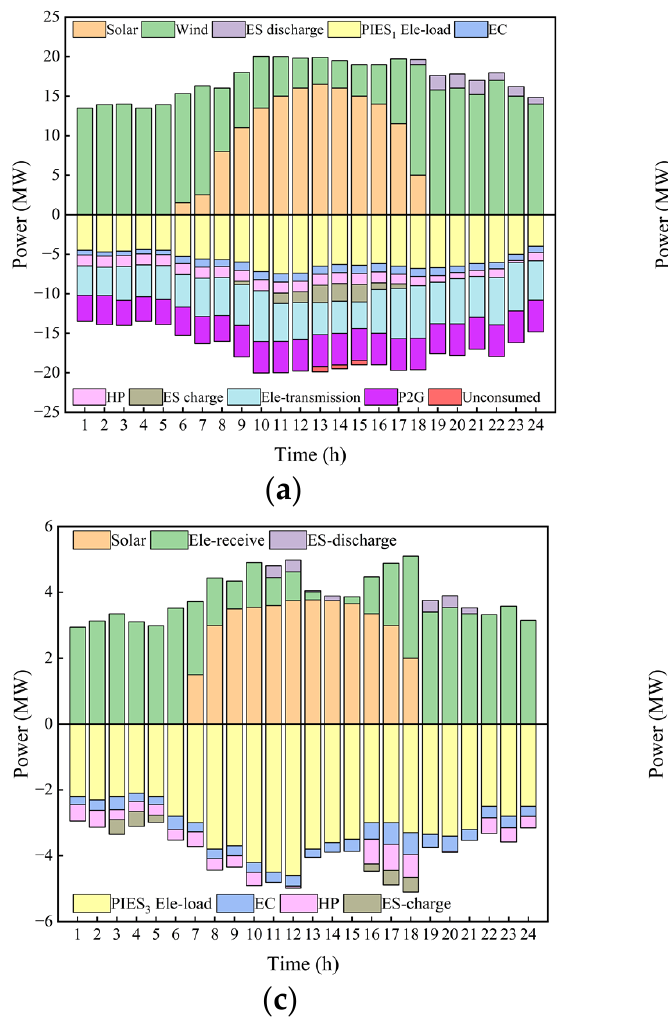
Figure 17. PIES 1 gas network for scenario 4. Table 2. Costs of a RIESG under different scenarios Cost/RMB